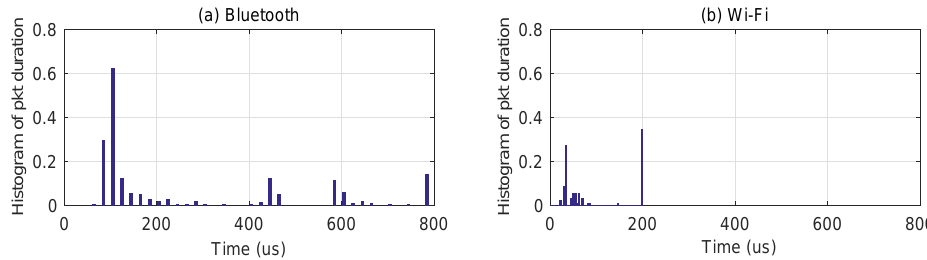
Figure 10. The normalized histograms of packet duration of Bluetooth and Wi-Fi, derived by applying threshold of − 65 dB to the RSSI traces, which are obtained at a 1-MHz sampling rate and averaged over 20 µ s. The scale of the graph is zoomed to the range [0, 800] µ s for visualization